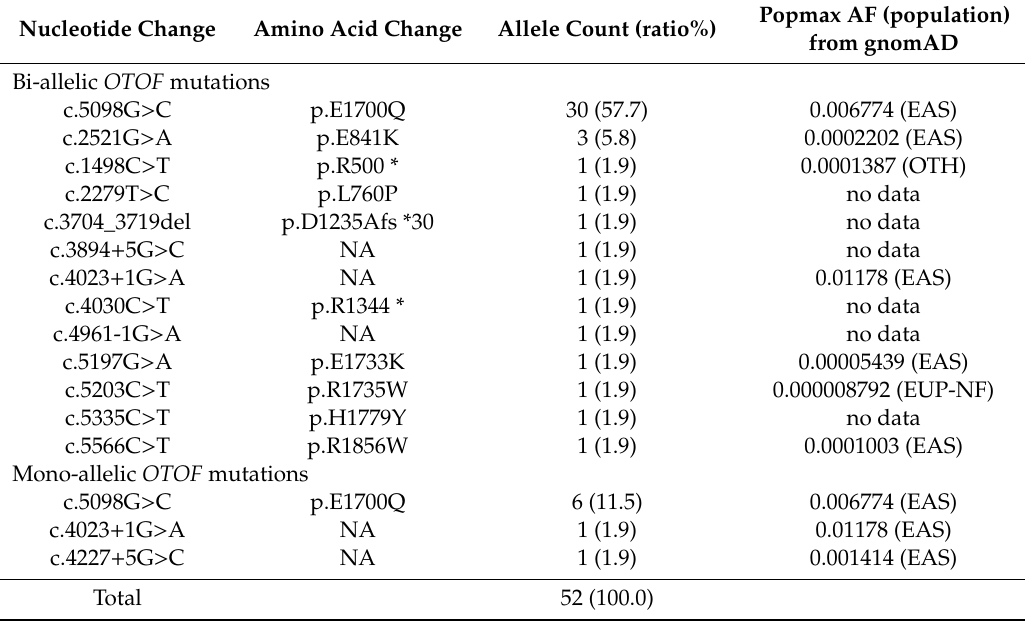
Table 4. OTOF mutations detected in 30 Taiwanese families with auditory